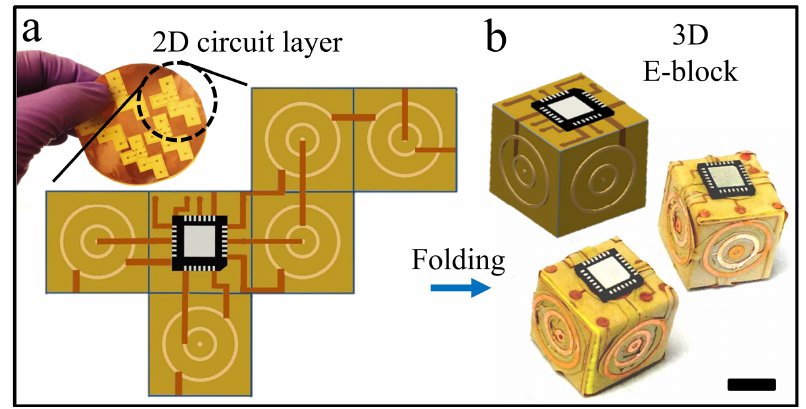
Figure 1. Layout for folded E-blocks. ( a ) Schematic and experimental photograph illustrating the two dimensional (2D) mapping of circuit layers designed for a three dimensional (3D) cubic E-block; ( b ) Schematic and photograph of an experimentally realized 3D folded E-block monomer. Scale bar is 5 mm.